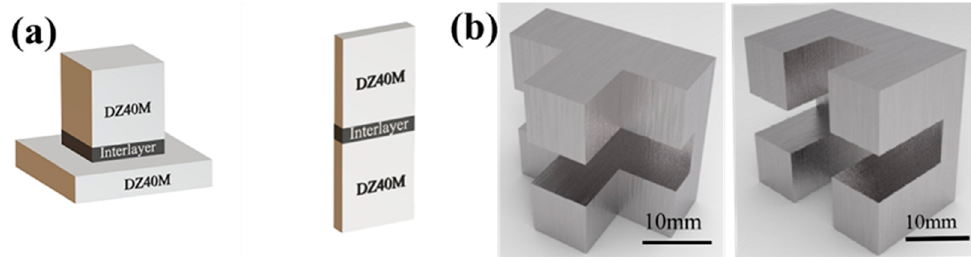
Figure 1. ( a )Sketches of the assemblies sample, ( b ) Graphite fixture for fixing